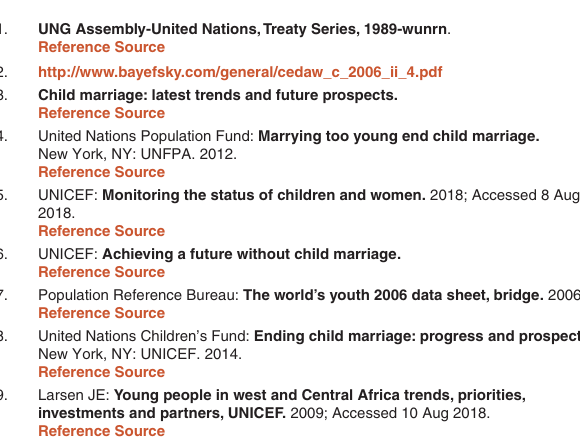
Figshare: Social and cultural factors perpetuating early marriage in rural Gambia: an exploratory mixed methods study. https://doi.org/10.6084/m9.figshare.10055516.v1 43 . This project contains de-identified summary transcripts of focus group discussions. Focus group transcripts. Figshare: Social and cultural factors perpetuating early mar- riage in rural Gambia: an exploratory mixed methods study.